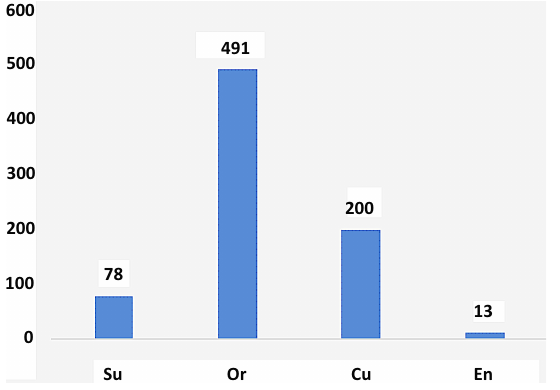
Figure 14. The risk generation scores of each part of the supply